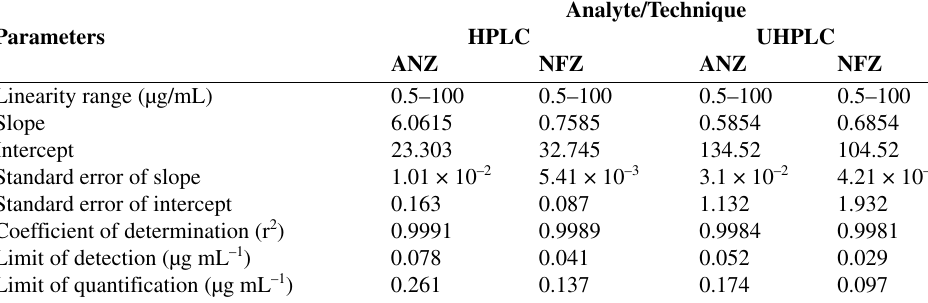
Table 4. Accuracy studies of ANZ and NFZ by HPLC and UHPLC Spiked